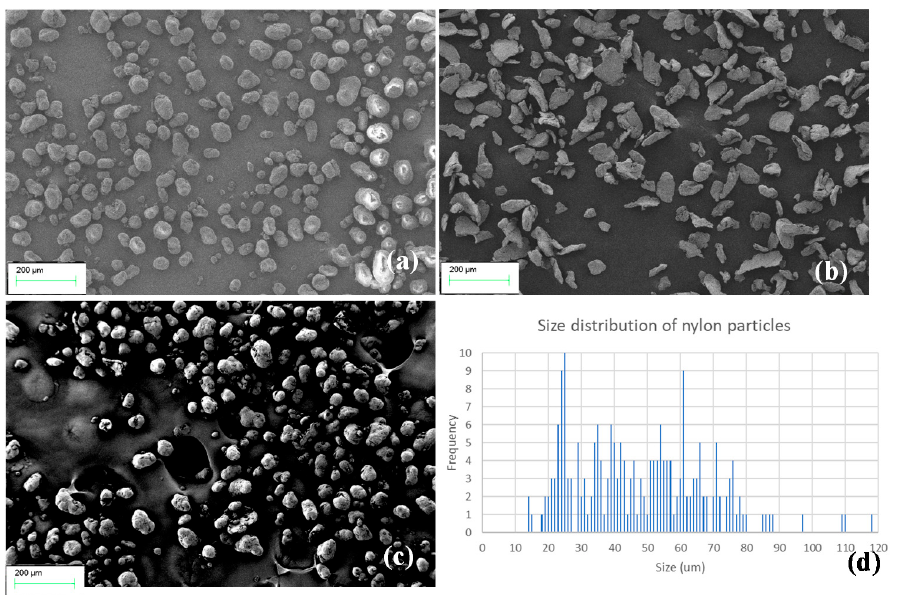
Figure 2. SEM images: ( a ) waste nylon powder; ( b ) Mg powder; ( c ) 8% Mg mixture; ( d ) size distribution of waste nylon powder.